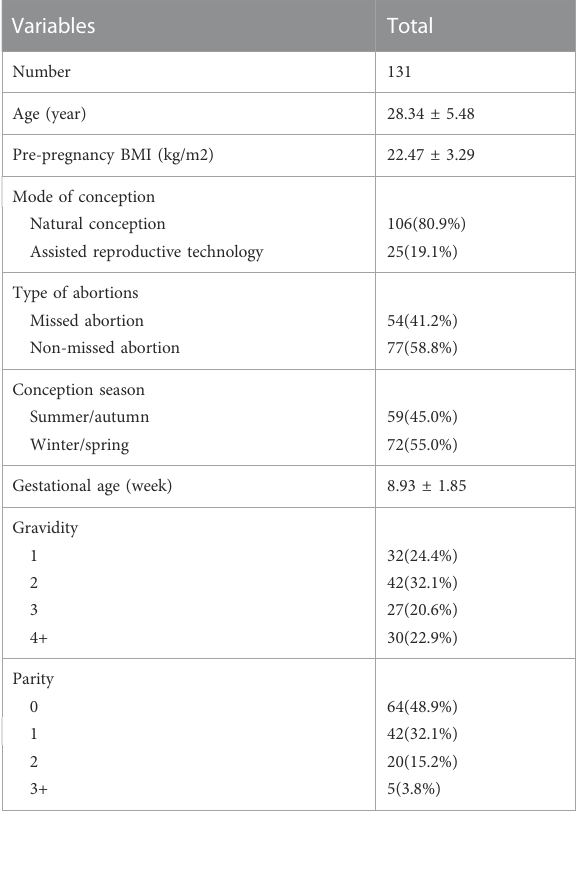
TABLE 1 Description of the abortion women ’ s characteristics.